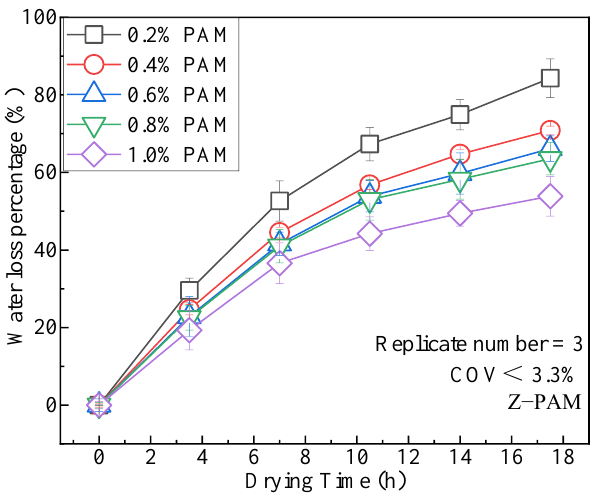
Figure 4. The moisture content of the compacted clay mixed with different PAM contents. Figure 5 reflects the influence of ZP content on the water loss of the compacted clay after drying. After 17.5 h of drying at 100 °C, the water loss rates of the compacted clay mixed with different contents of ZP were 84%, 71%, 66%, 64%, and 54%, as the ZP content ranged from 0.2% to 1.0%. Therefore, increasing the content of modifier ZP can effectively reduce the water loss rate of clay and improve its WRC. Studies have indicated that the water loss of the clay mixed with various ordinary agricultural and forestry water-retaining agents varies from 55% to 63%, after they are dried for 360 min with a temperature of 60 °C [53]. However, when our research used 0.8% and 1.0% ZP for modification, the water loss rates of the clay after drying at 100 °C for 17.5 h were 64% and 54%. Furthermore, field monitoring results in the Changzhou contaminated site showed that [18] the highest atmospheric temperature was 45 °C, which was much lower than the test temperature of 100 °C in this paper. As a result, ZP plays a more prominent role in enhancing the WRC of CCC under low temperatures of 45 °C rather than 100 °C.